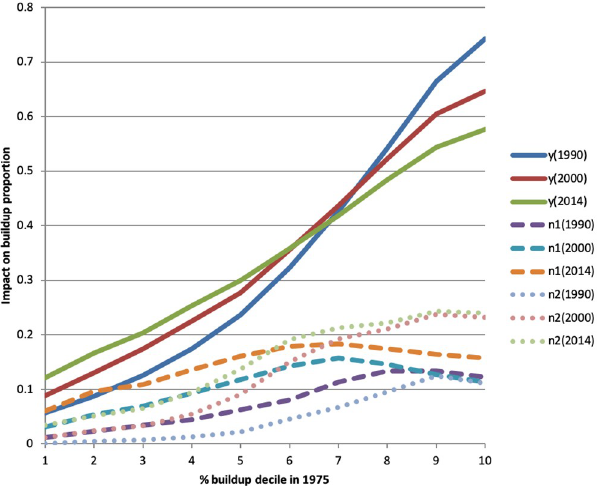
Fig 9. Fig 9 summarizes the coefficients from three separate regressions. The dependent variable in the three regressions is the proportion of a cell that is built up in 1990, 2000, and 2014 respectively. Each regression includes the 1975 values of buildup in the cell and in the neighboring cells n1 and n2. Each of the three 1975 buildup variables appears in the regression as a series of 10 dummies, one per buildup decile. The Figure shows the estimated decile coefficients in each of the three regressions for (1) 1975 buildup in the cell [lines y(1990), y(2000) and y(2014)]; 1975 buildup in neighboring cells n1 [lines n1(1990), n1(2000), and n1(2014)]; and 975 buildup in neighboring cells n2 [lines n2(1990), n2(2000), n2(2014)]. Each regression also includes all the road presence dummies for 1976 (see Fig 10) and the following time invariant regressors: longitude, latitude, and their product [three variables]; soil humidity and soil quality dummies [six variables]; and dummies for the presence of a water body, a land border, or the sea in the cell, the neighboring cells n1 and the neighboring cells n2, respectively [9 variables]. The number of observations in each regression is just shy of 3.8 million. R-squares are 0.799, 0.711 and 0.582, respectively. All coefficients shown here are significant at the 1% or